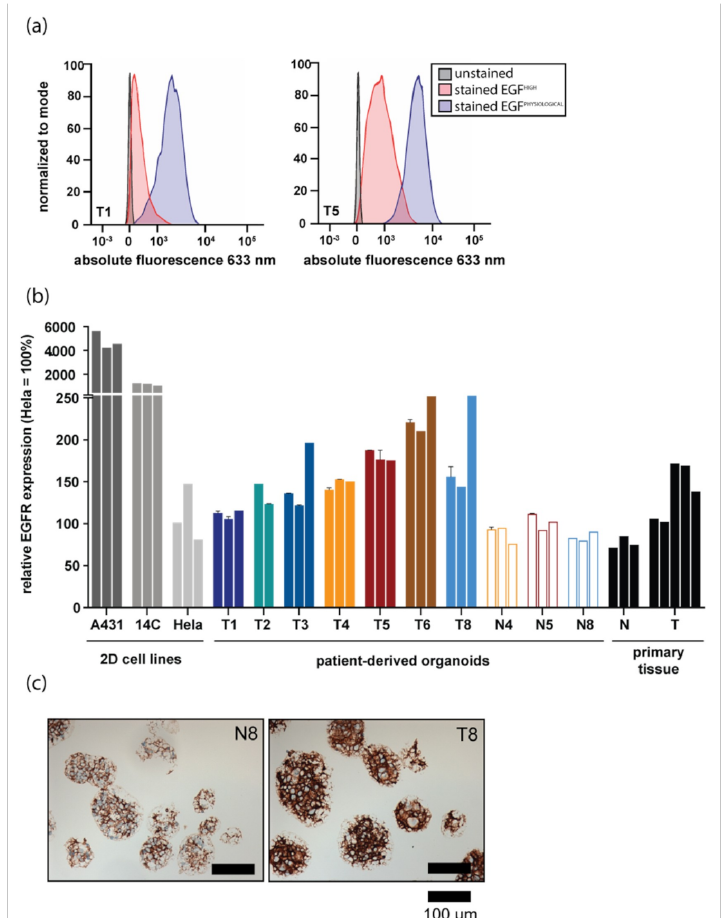
Figure 1. Epidermal Growth Factor Receptor (EGFR) expression di ff ers between patient-derived organoids from di ff erent donors and recapitulates EGFR levels of respective tissues. ( a ) EGFR protein expression detected by flow cytometry. EGFR expression of organoids grown in either physiological Epidermal Growth Factor (EGF) (blue peak) or high EGF (ref peak) medium is shown for two HNSCC organoid lines. An unstained control is shown in black. ( b ) EGFR protein expression measured by flow cytometry in 2D cell lines commonly used in in vitro EGFR-targeted PDT studies, organoid lines derived from HNSCC patients both normal and tumor, and in primary tissue samples. For organoids, the experiment was performed in technical duplicate (error bars) and biological triplicate (individual bars). EGFR expression was stable over time, as biological replicates were measured two months apart. EGFR protein levels are shown relative to HeLa cells (set at 100%). Results of tumor organoids are shown in filled bars, results of wildtype organoids are shown in clear, outlined bars. For primary tissues, each bar represents EGFR expression on a tissue sample derived from an individual patient. ( c ) EGFR immunohistochemical staining performed on N8 and T8 organoids. Scalebar, 100 µ m. As organoid culture allows for the expansion of corresponding normal tissue in culture, EGFR levels of organoid grown from surrounding normal tissues were also measured. For three donors, EGFR levels on both normal and tumor organoids were compared. In all cases, EGFR protein levels detected on tumor cells were higher than those detected on matched normal organoids (Figure 1b). Importantly, EGFR expression levels in organoids (colored bars) were comparable to EGFR levels of primary patient material samples (black bars indicated with ‘primary tissue’, Figure 1b). The observed di ff erences in EGFR expression between normal and tumor organoids were confirmed using immunohistochemistry (Figure